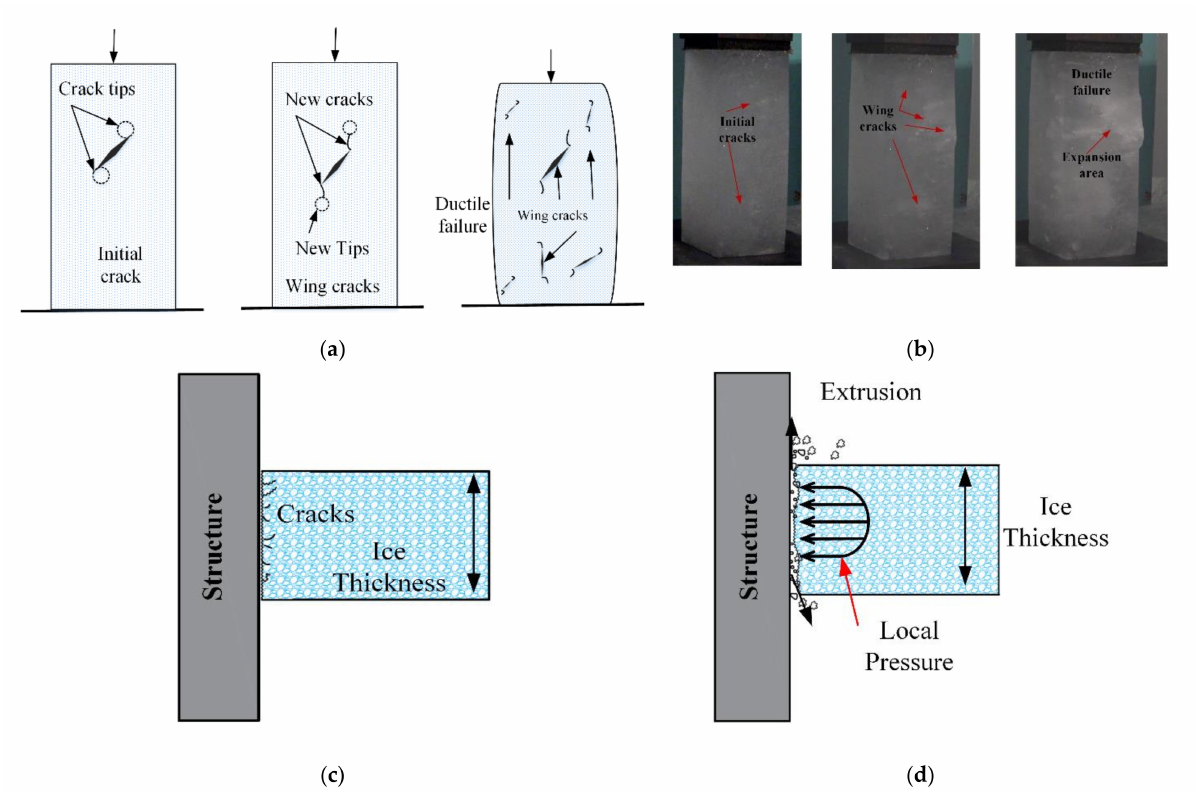
Figure 1. Crack growth at a low loading speed and the theoretical crushing process in front of the vertical structure. ( a ) Schematic of internal crack propagation, ( b ) Uniaxial compressive test at a strain rate of 10 − 4 s − 1 , ( c ) Initial crack formation in the sea ice in front of the structure, ( d ) Local ice pressure and ice fragmentation